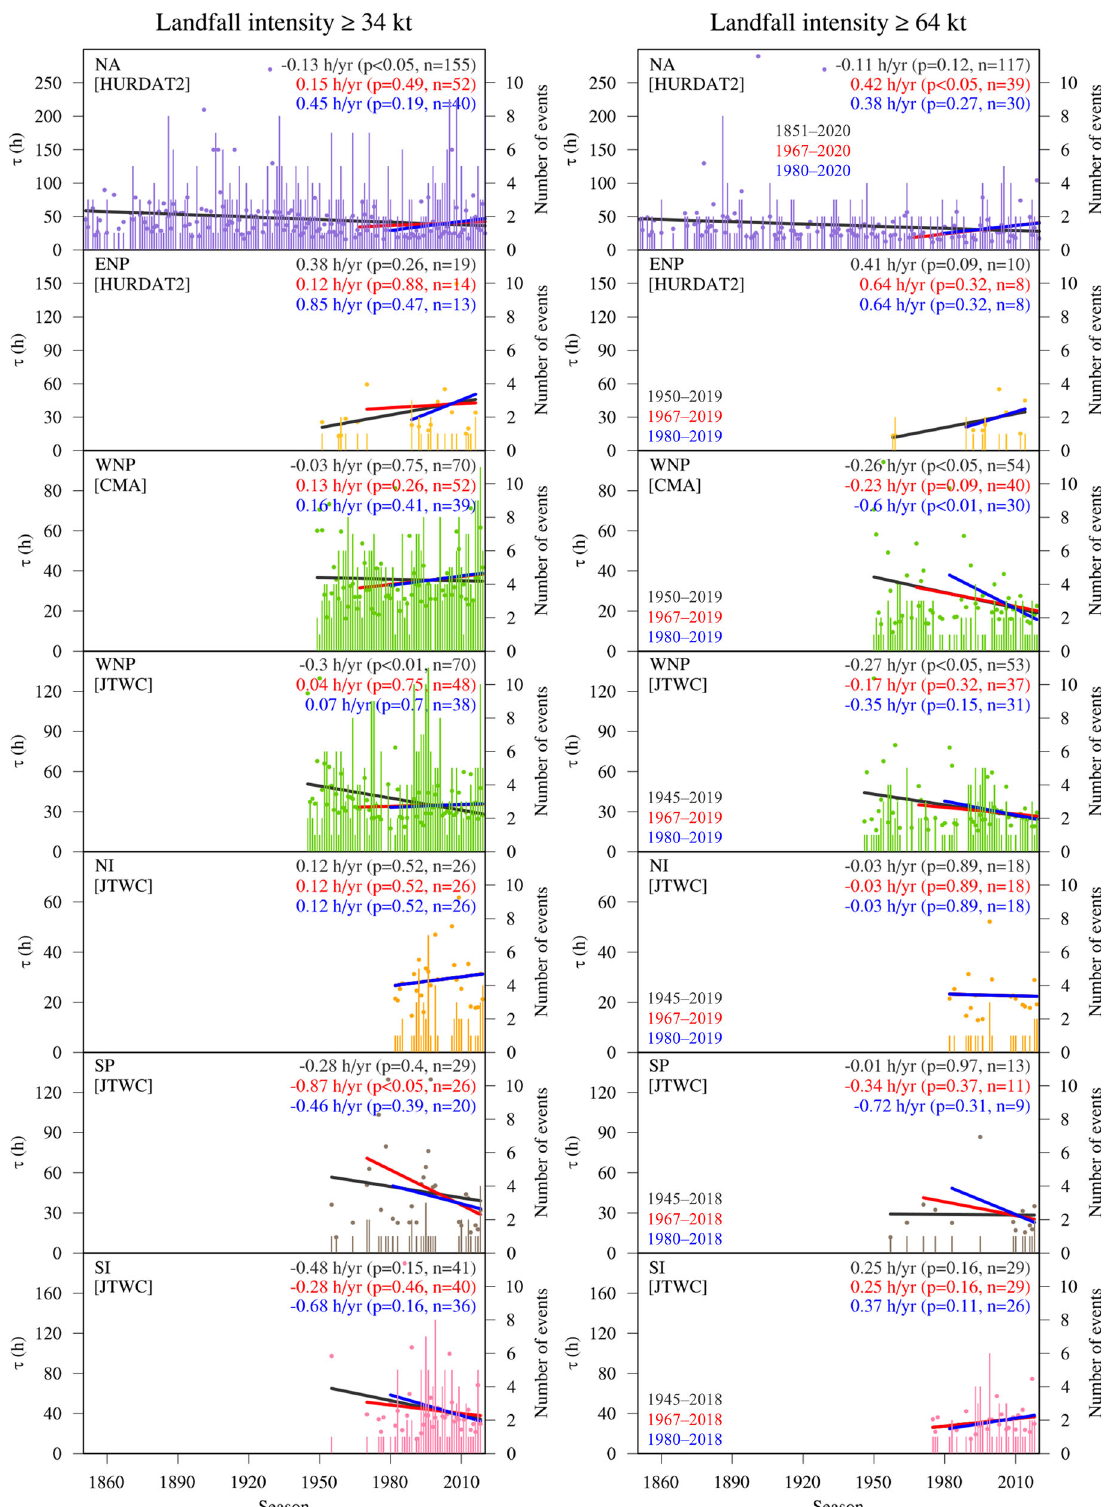
Fig. 1 Global climatology of the season-level decay of landfalling tropical cyclones. Left and right columns show the time series of the season-level τ (dots) and numbers of landfall events (bars) of tropical cyclones from individual basins with landfall intensity ≥ 34 kt and ≥ 64 kt, respectively (NA North Atlantic; WNP western North Paci fi c; NI North Indian Ocean; SP South Paci fi c; SI South Indian Ocean). Corresponding linear regression trends (lines), p values, and number of seasons n over different study periods are